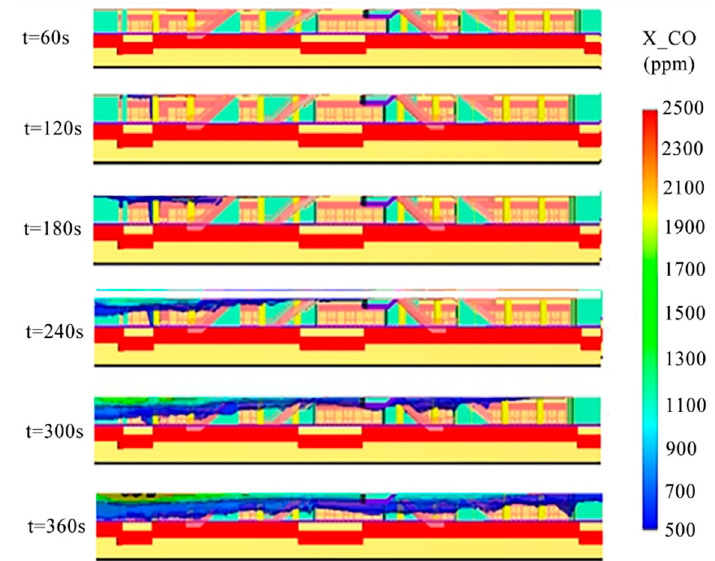
Figure 7. CO concentration of fire at the end of the platform.